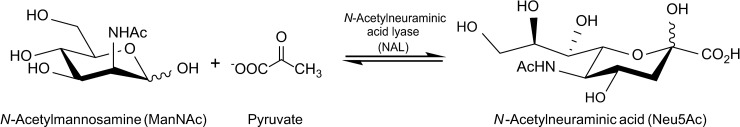
The reversible condensation reaction between ManNAc and pyruvate giving Neu5Ac catalyzed by NAL.